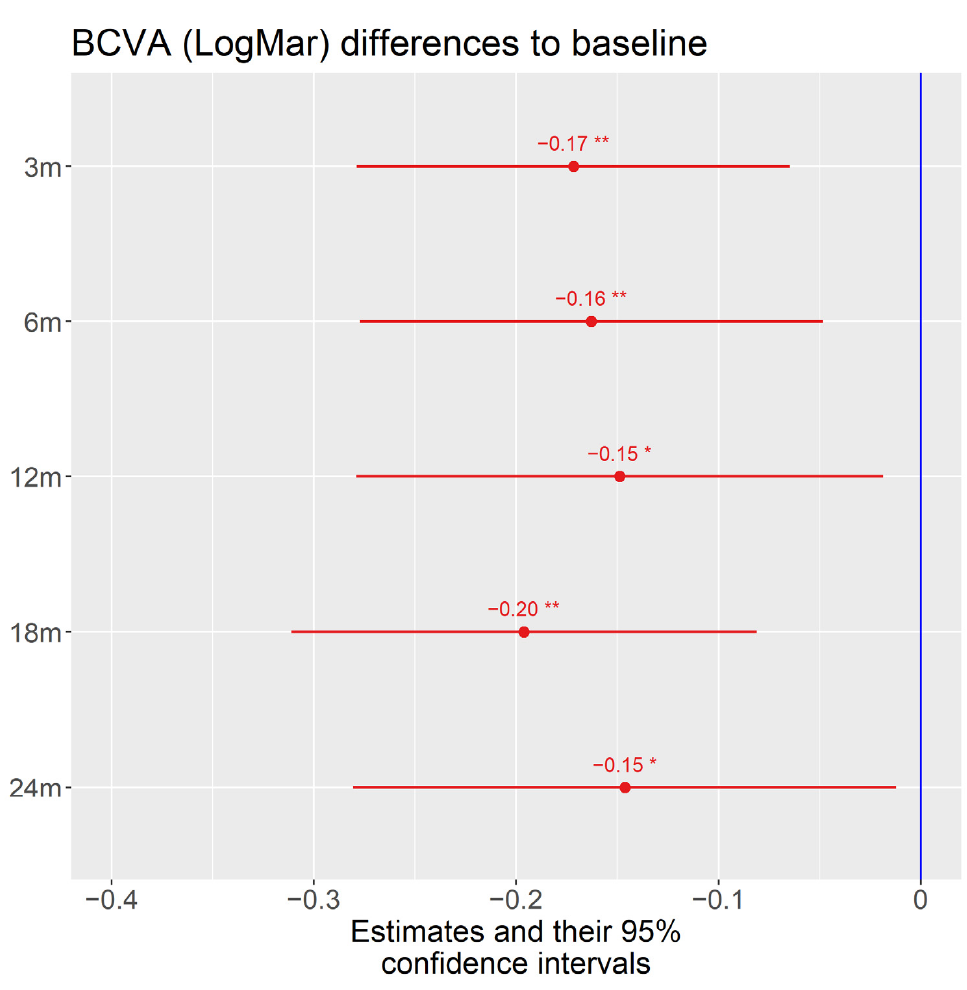
Figure 5. The estimates and their 95% confidence intervals in BCVA (logMar) from baseline. A total 157 BCVA data were used for the analysis. The overall effect of time was significant, F (5122) = 2.35, p = 0.045. Visual acuity at FU1 (month 3) and FU4 (month 18) was significantly different from initial visual acuity when performing pairwise comparisons between all time intervals and adjusting p -values. Other pairwise comparisons were not statistically significant p > 0.05. The data were analyzed via mixed regression modeling @pinheiro2006mixed. (Note: Some severe cases with bad vision caused decreased mean values for visual acuity, which led to large standard errors and, thus, less statistical significance. For this reason we applied robust mixed regression as well to confirm the findings. In this model, all mean values during treatment were statistically significantly different from baseline but the magnitude of change was somewhat less than estimated with the nonrobust method. All changes during treatment were estimated to be of around 1 Snellen line ( − 0.1 LogMar change)). FU1: 3-month visit (3 m), FU2: 6-month visit, (6 m) FU3: 12-month visit 12 m), FU4: 18-month